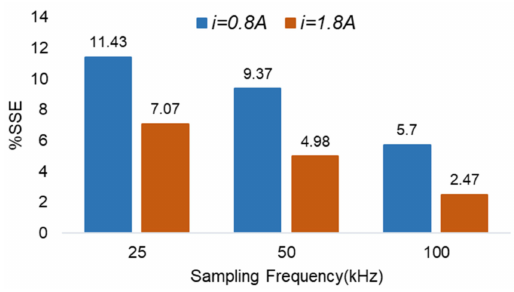
Figure 16. Steady-state error (SSE) performance for FS-MPC.